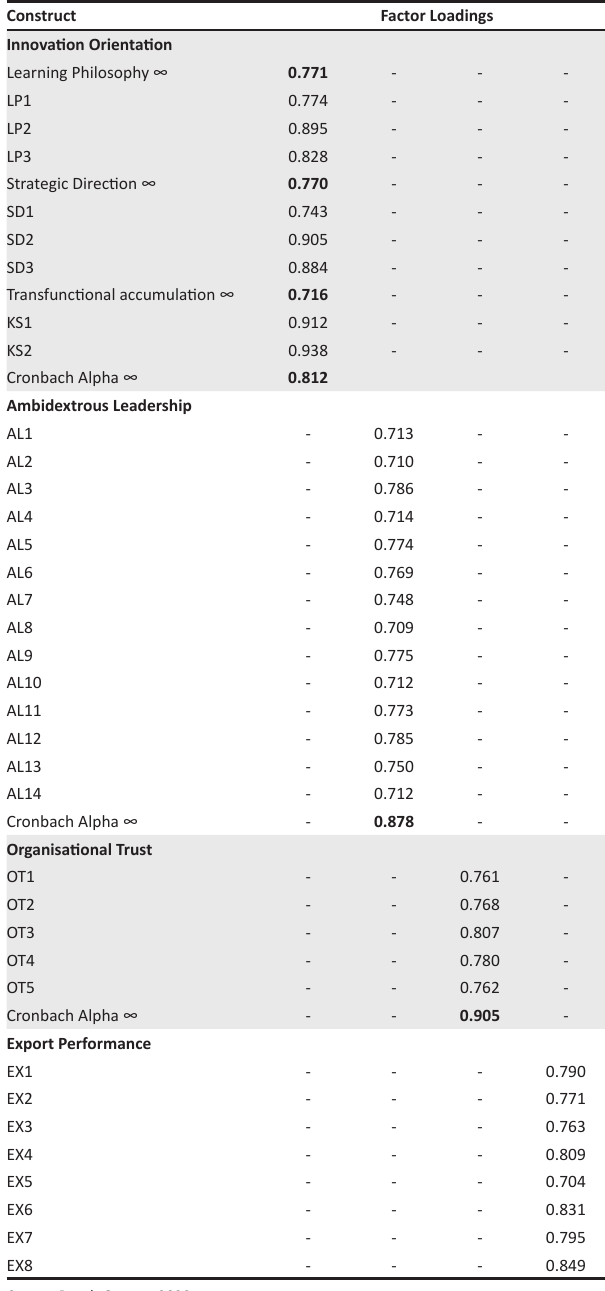
TABLE 2: Measurement Result on Ambidextrous Leadership, Innovation Orientation, Organisational Trust and Export performance.